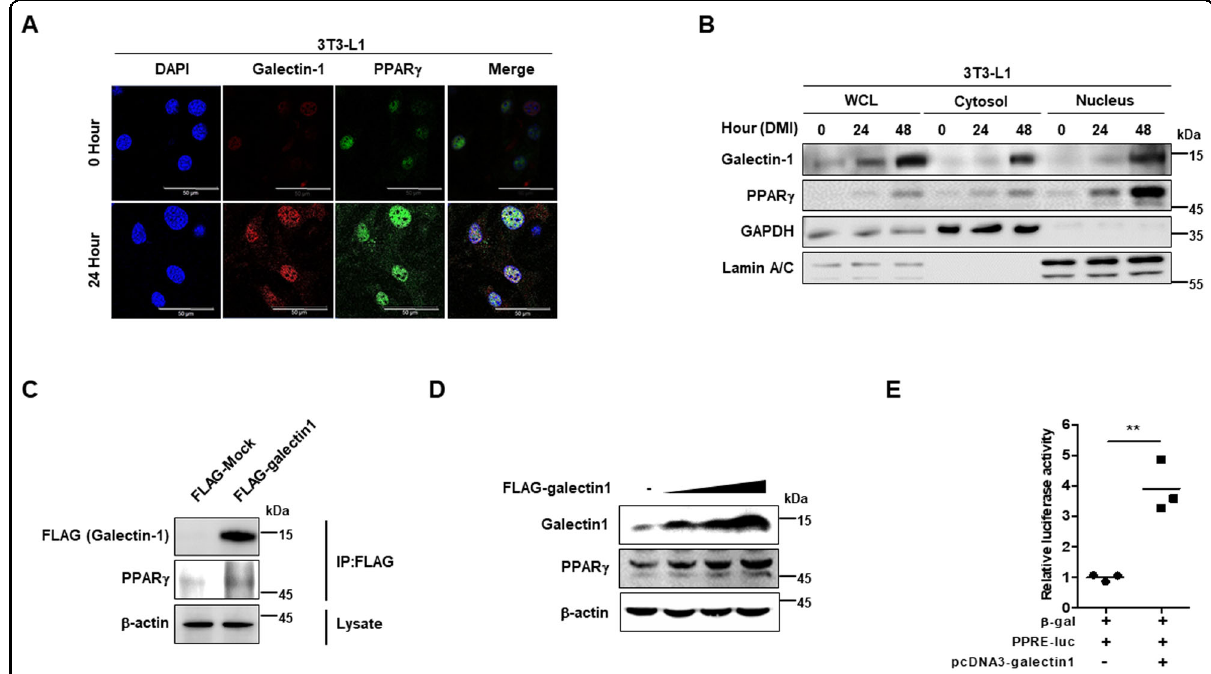
Fig. 3 Galectin-1 interacted with PPAR γ . a Detection of localization of galectin-1 and PPAR γ after DMI treatment in preadipocyte 3T3-L1 cells by confocal microscopy. Galectin-1 was stained with cy5-conjugated antibody and PPAR γ with FITC-conjugated antibody. DAPI was used for nuclear staining. Bars indicated 50 μ m. b Cellular localization and expression level of galectin-1 and PPAR γ were analyzed by western blotting using nuclear and cytosolic fractions of 3T3-L1 cells. GAPDH and Lamin A/C expression levels were detected and used as loading controls. c Immunoprecipitation of galectin-1 and PPAR γ was performed in human embryonic kidney 293 (HEK293) cells. Cell lysates were immuneprecipitated using anti-Flag beads. β -actin expression was detected by western blotting as a loading control. d Flag-tagged galectin-1 overexpression vector was transfected in HEK293 cells and endogenous PPAR γ expression was detected by western blotting. β -actin expression was used as a loading control. e Detection of luciferase activity of PPAR-response element (PPRE) by galectin-1 overexpression. Luciferase activity of PPRE was normalized to β -gal activity. Data are presented as the mean ± SEM. ** p < 0.01 for the mock-transfected group vs. the galectin-1-overexpression